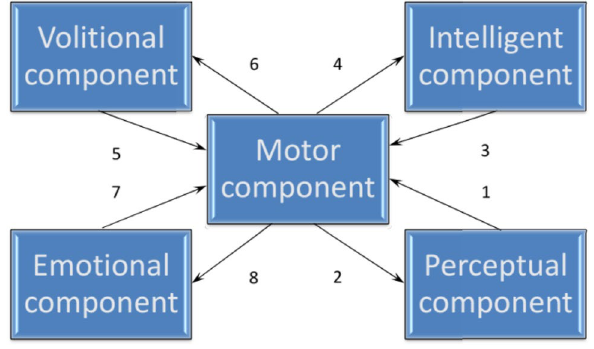
Fig. 1 Data/information streams between core